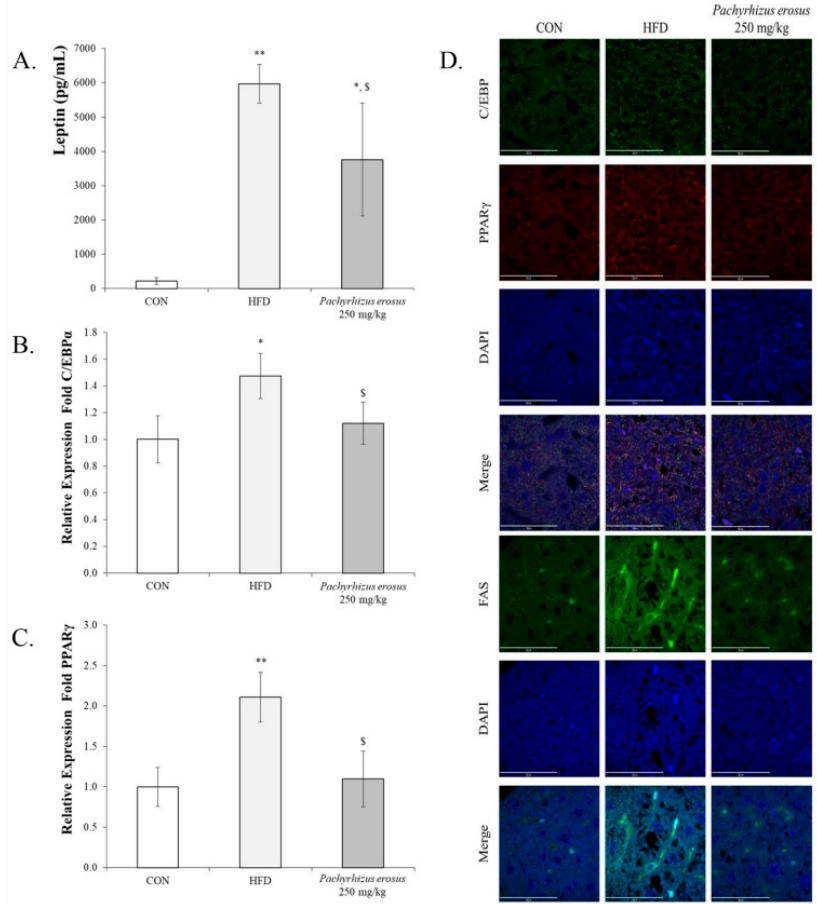
Figure 5. P. erosus inhibited adipogenesis via leptin-C/EBP α -PPAR γ and FAS. ( A ) P. erosus down- regulated the level of leptin in the liver, which was significantly increased by HFD. ( B ) P. erosus decreased the relative expression of C/EBP α from 1.5 ± 0.17 fold to 1.1 ± 0.16 fold. ( C ) P. erosus effectively decreased the expression level of PPAR γ from 2.1 ± 0.30 fold to 1.0 ± 0.34 fold. The results are described as a mean ± standard deviation. N = 12. * p < 0.05 vs. control; ** p < 0.001 vs. control; $ p < 0.05 vs. HFD-induced obesity. ( D ) P. erosus effectively controlled the adipogenesis-related factors such as C/EBP α , PPAR γ , and FAS in the liver. Scale bar, 50 μ m. Magnification, ×1000.